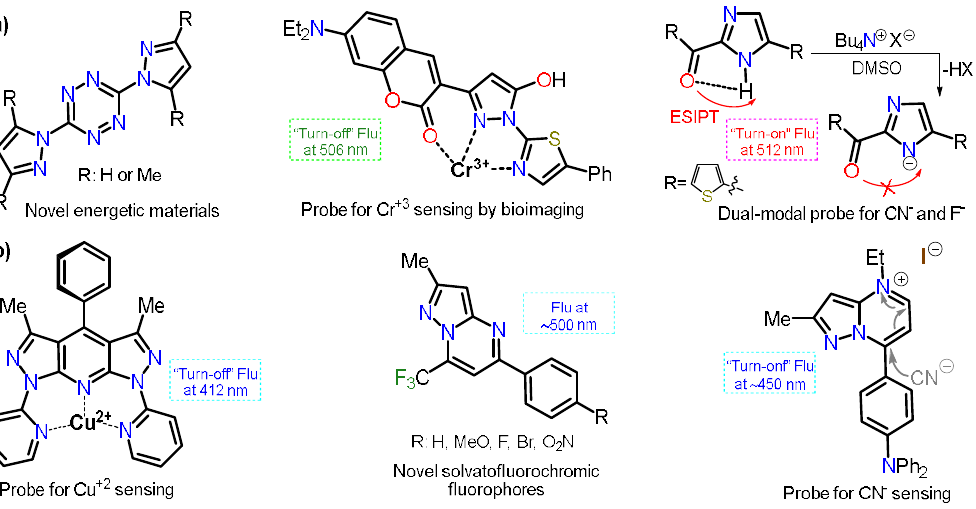
Figure 2. Structure of different drugs based on ( a ) pyrazoles and ( b ) some of their 5:6 fused systems. Inside the last-mentioned features, the photophysical properties have been exten- sively studied because they allow research in environmental, biological, and industrial fields; these features in N -heteroaromatic pyrazole derivatives are unique given that sat- urated NHCps behave analogously to open-chain compounds. Thus, pyrazole deriva- tives with conjugation properties tend to be molecules with unique and intrinsic photo- physical properties, which can be employed to develop sensors and organic materials [17–21]. One of the most studied topics is the detection of ions [7,20,21] (Figure 3).